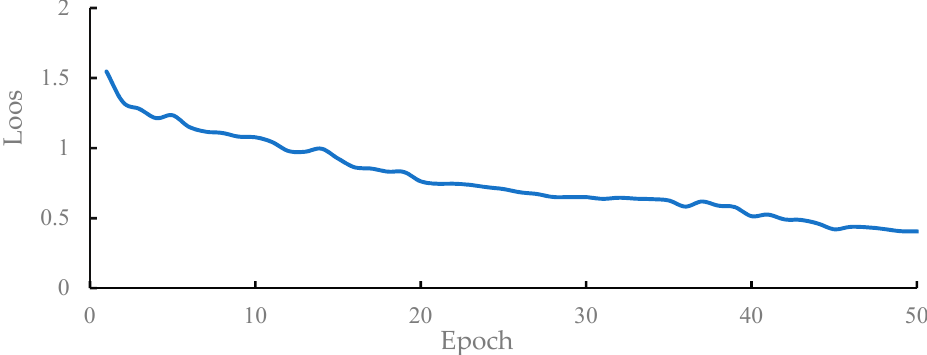
Figure 8. The LOSS changes based on the NYU-V2 dataset.